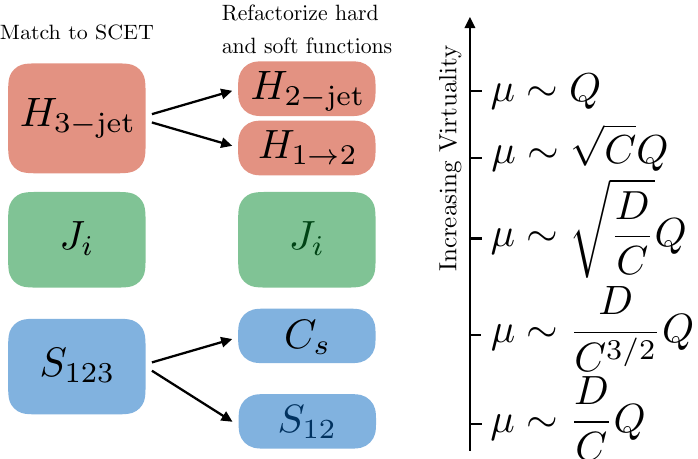
Figure 2. Illustration of the re-factorization and natural scales of the functions appearing in the factorization theorem of the collinear hierarchal trijets phase space